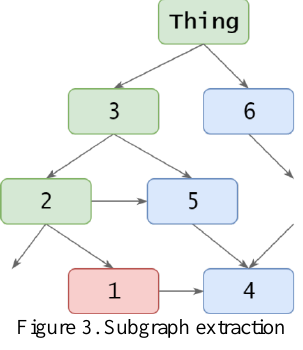
Figure 3. Subgraph extraction